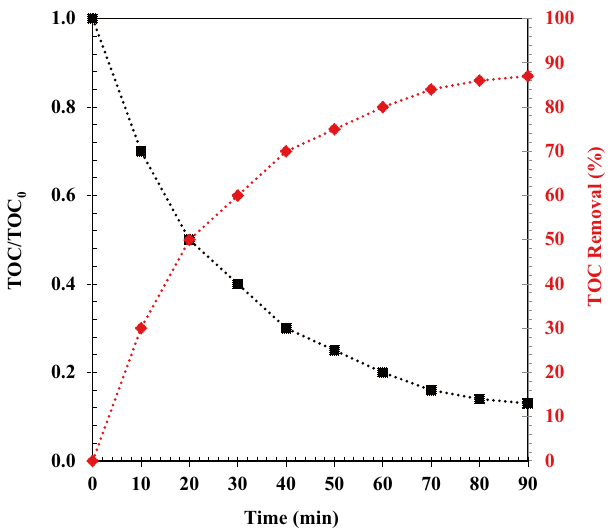
Figure 16. Total organic carbon (TOC) in naproxen wastewater as a function of time and the ZrO 2 /TiO 2 /Fe 3 O 4 photocatalytic activity.